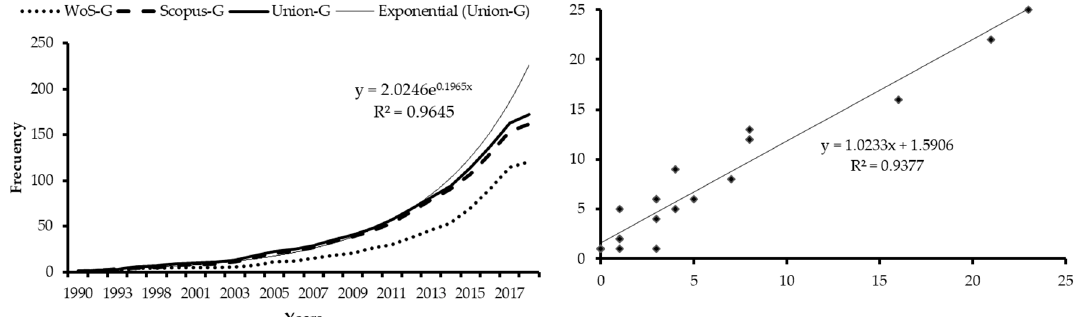
Figure 2. Production: Growth and Correlation for years. Source: own elaboration.